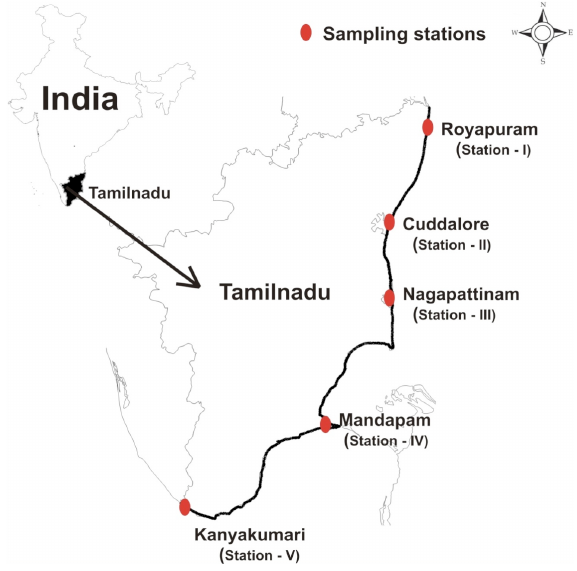
Figure 1. Sampling stations along Tamil Nadu, southeastern coast of